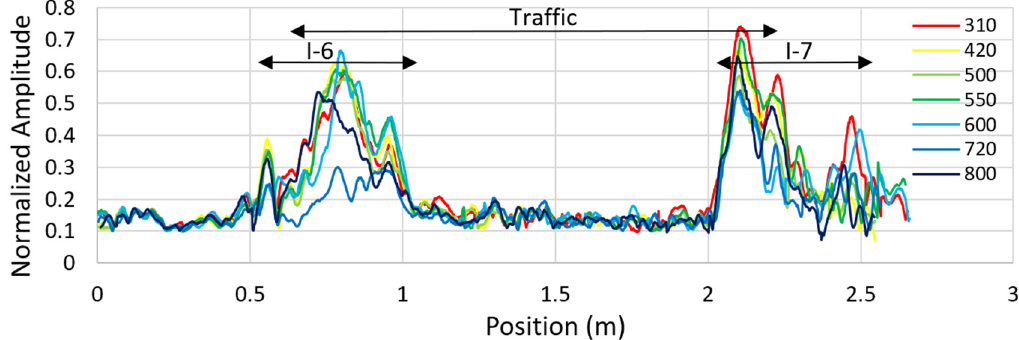
Figure 32. 2.6 GHz Normalized RW amplitudes on defects I-6 and I-7, in the transversal direction vs. K loadings.